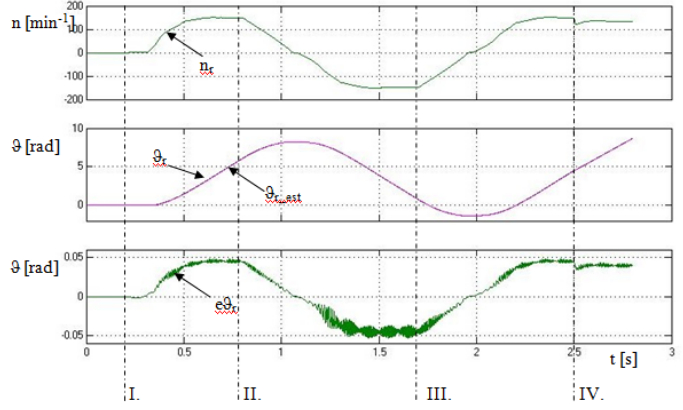
Figure 24. Real and estimated rotor position comparison for different working modes